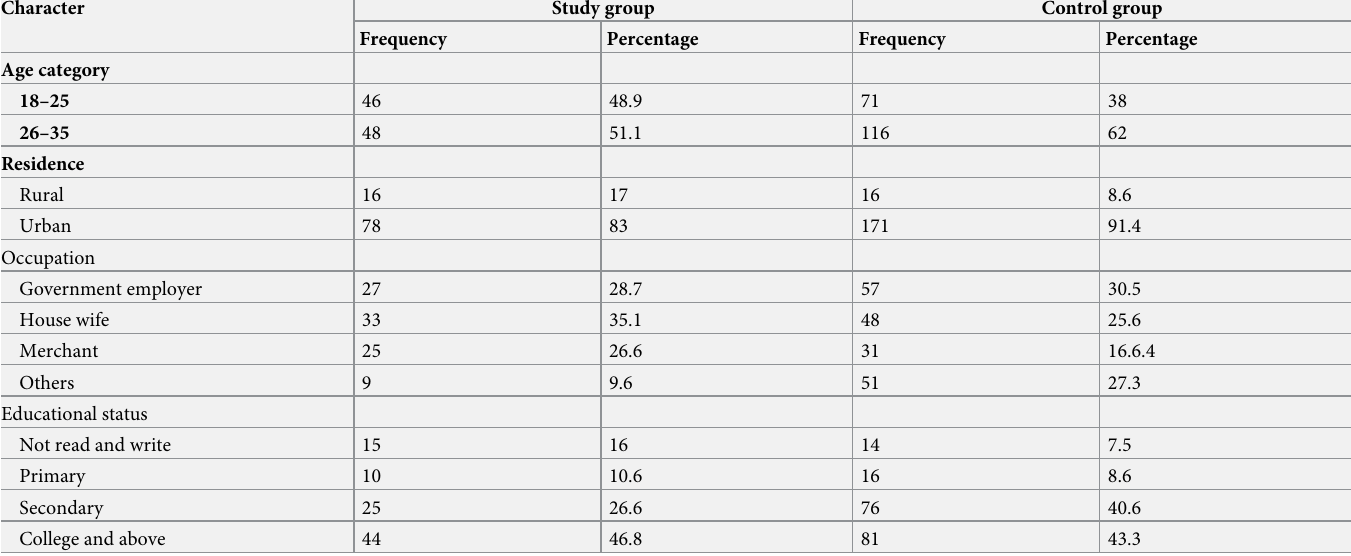
Table 1. Socio-demographic characteristics of study participants attending antenatal care at Debre Markos Referral Hospital from December 2017 to February 2019.